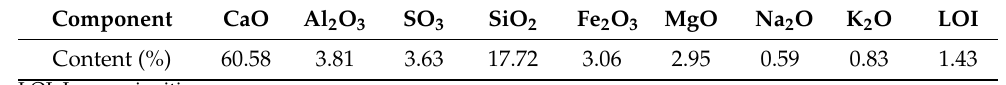
Table 1. Chemical composition of cement.